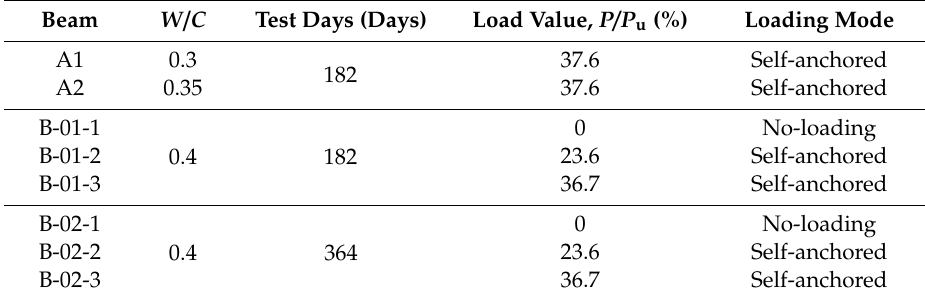
Table 3. Load value of the beams.